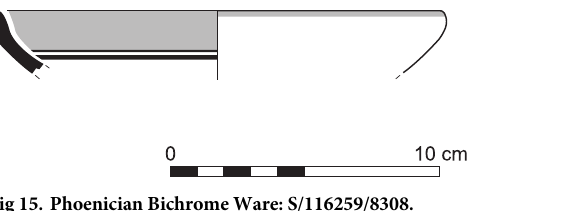
Fig 15. Phoenician Bichrome Ware: S/116259/8308.